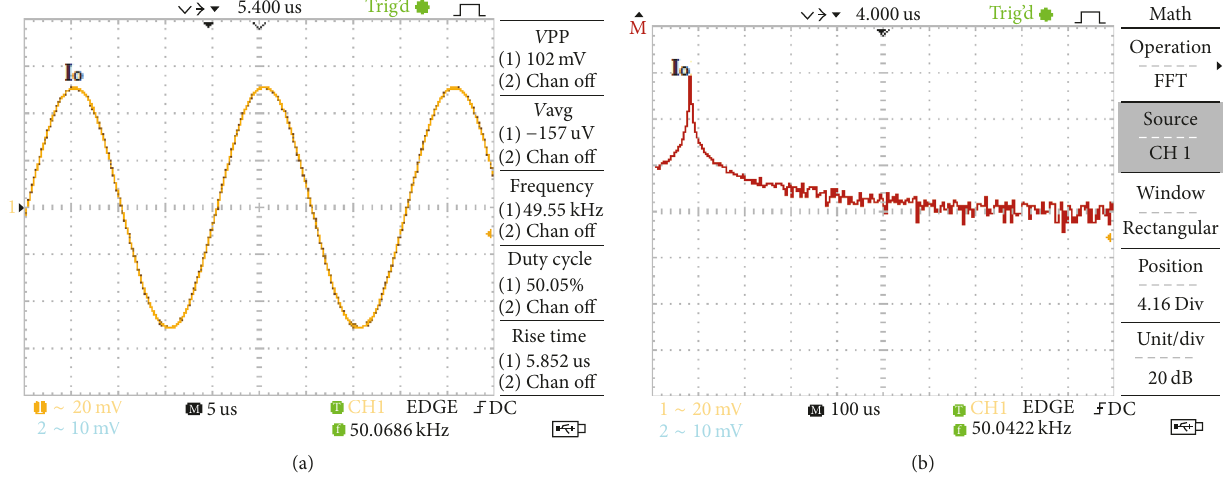
Figure 6: Measurement of output current and its spectrum at 𝑓 0 = 50